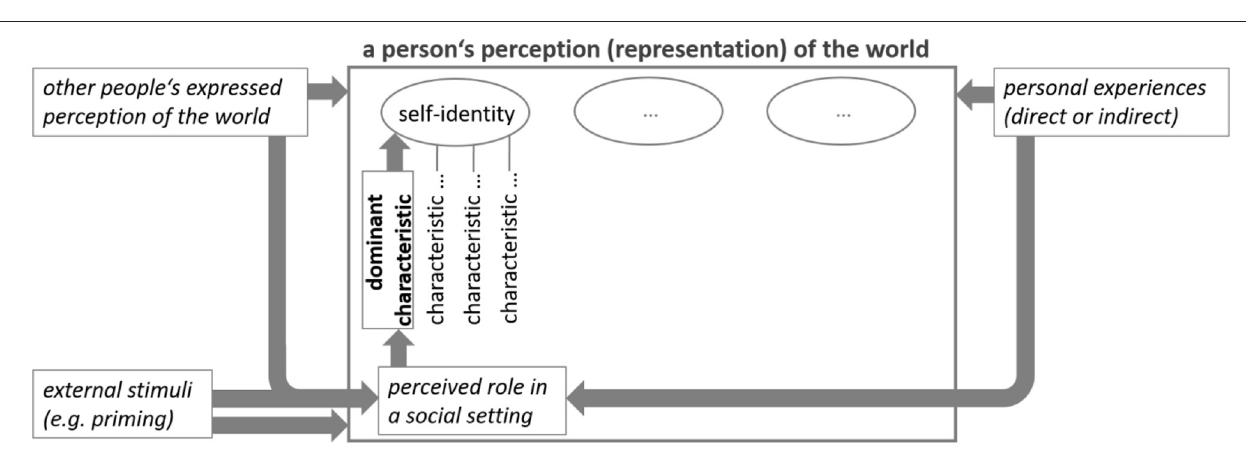
FIGURE 2 | Cultural socialization processes and personal traits that influence behavior decision